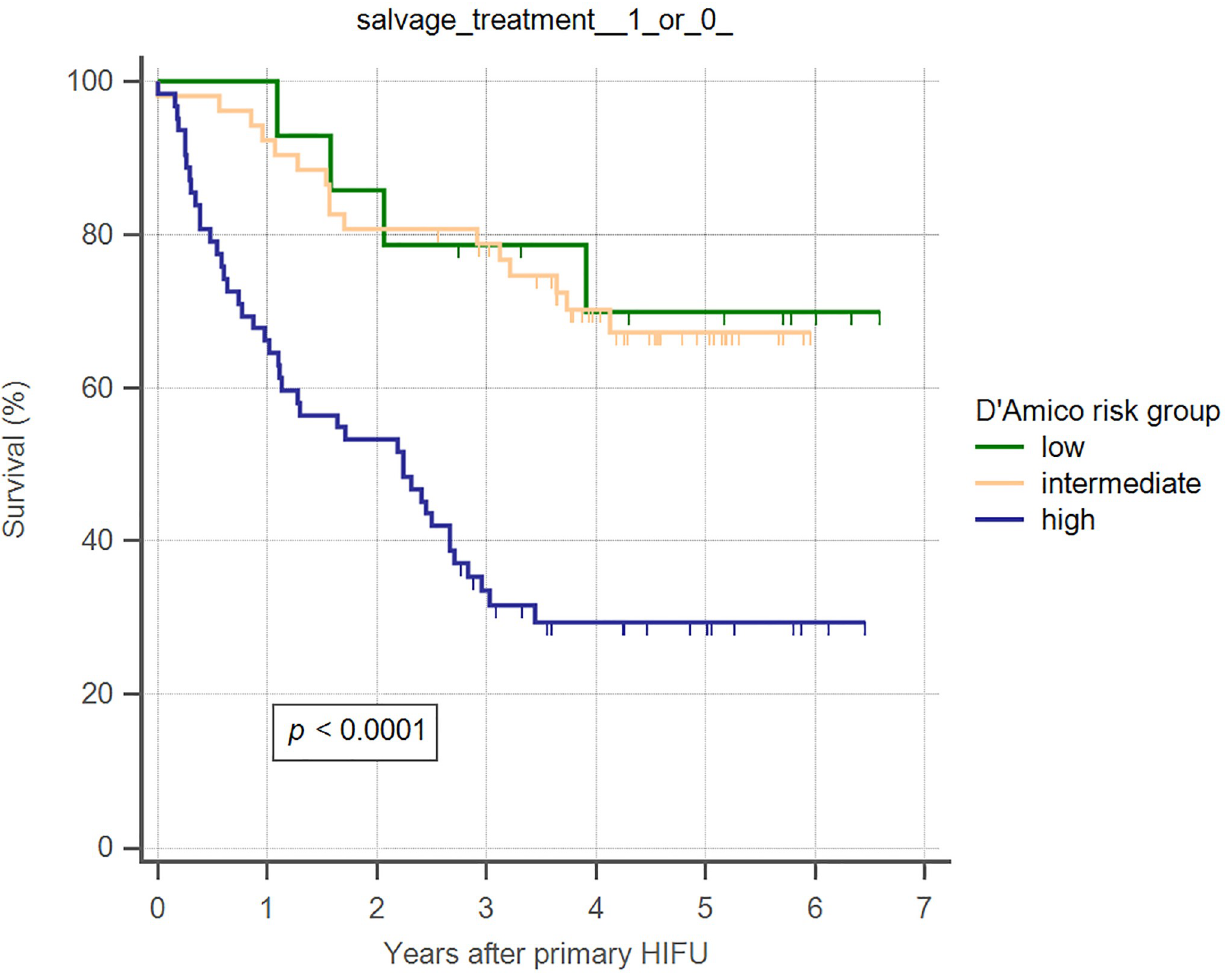
Fig 3. Kaplan–Meier curves illustrating salvage treatment–free survival, by D’Amico risk groups, in men undergoing WG-HIFU for prostate cancer.